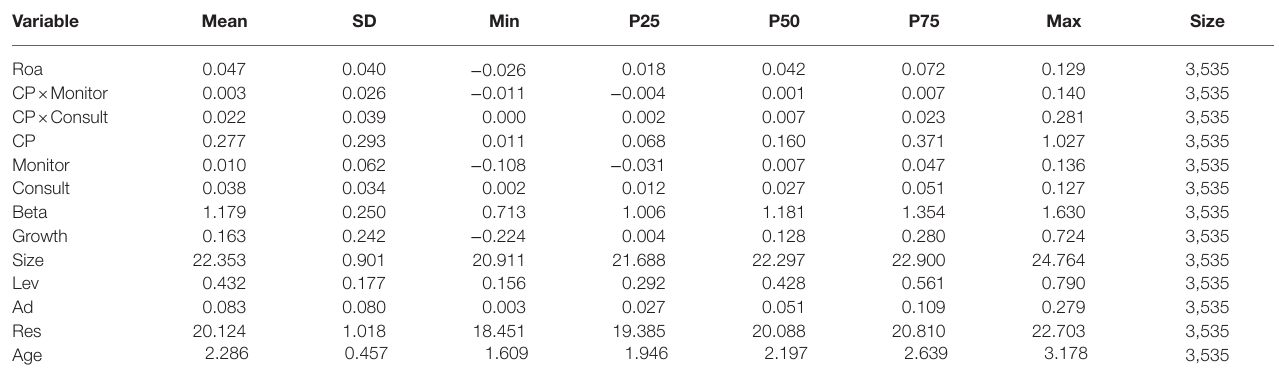
TABLE 2 | Descriptive statistics of the main variables (private enterprises).